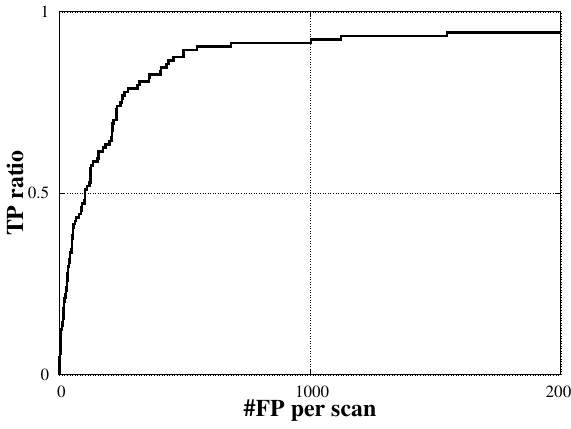
Figure 10. FROC curve of initial detection of all the agreement levels.